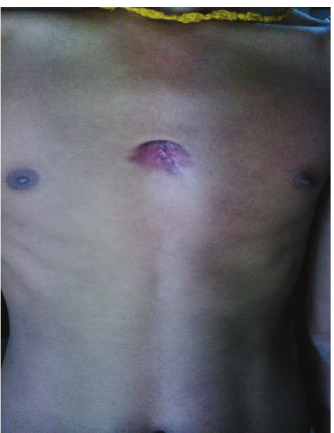
Figure 4: Showing the healed lesion on follow-up examination after 4 months of